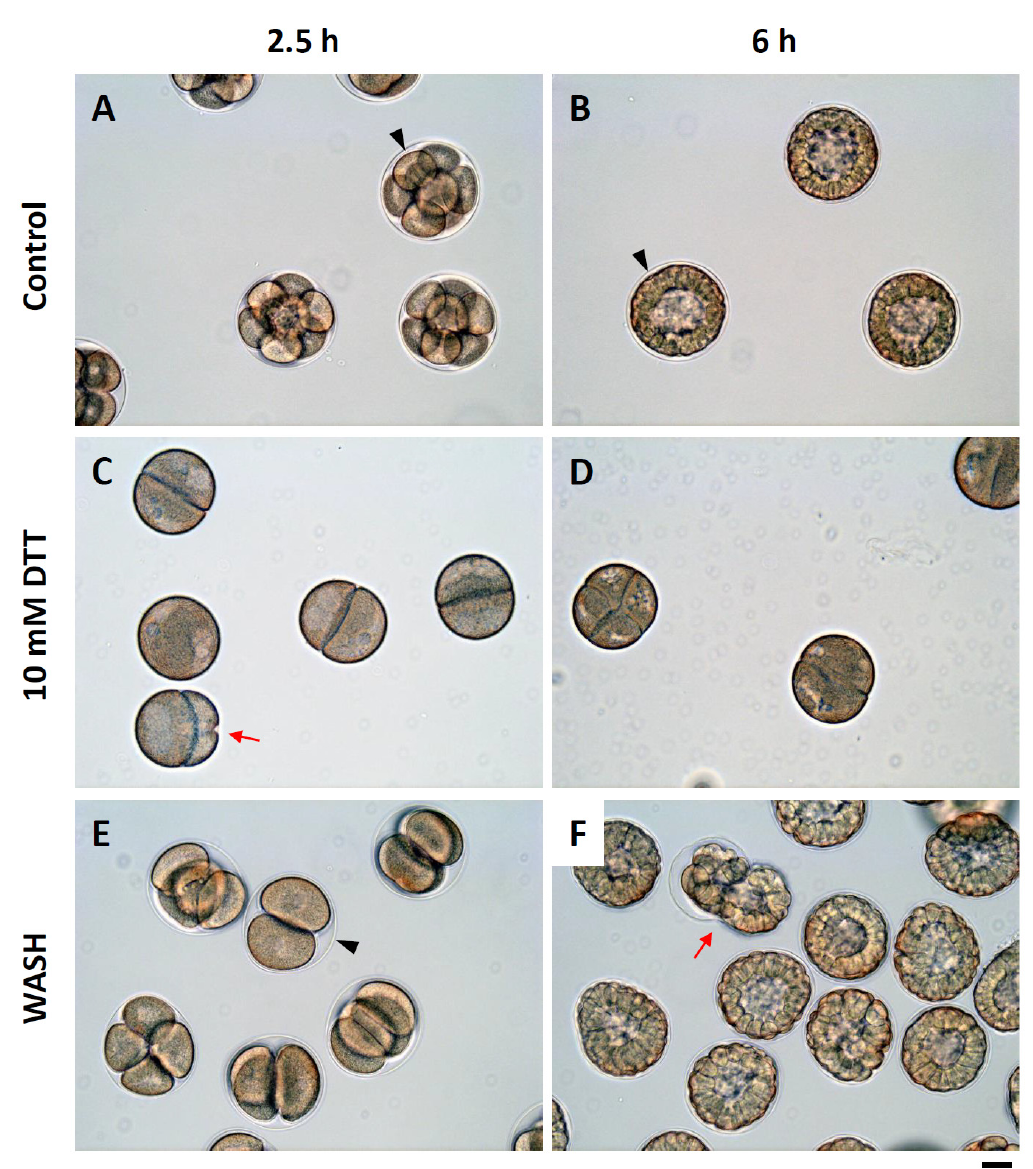
Figure 7. DTT pretreatment of the eggs induces anomalies during early development. ( A – D ) P. lividus eggs were incubated in the presence or absence (control) of 10 mM DTT for 10 min and fertilized. ( E – F ) Some of the DTT-pretreated eggs were rinsed and restored in NSW (10 min) and fertilized (WASH). The cleavage and development of the embryos in each condition were monitored by light microscopy. Arrowheads indicate the FE. Note that the FE covering the control embryo is still intact at 6 h ( B ), where it is totally absent in the embryos fertilized in the presence of DTT. The FE is evident again in the embryos derived from the eggs restored in NSW prior to fertilization ( F ). Red arrows indicate signs of leakage in the embryo from the ruptured FE. Scale bar, 10 μ m. FE, fertilization envelope. The number of fertilized eggs examined for each set of experiments was 100. Representative results from one of the three independent experiments are shown.